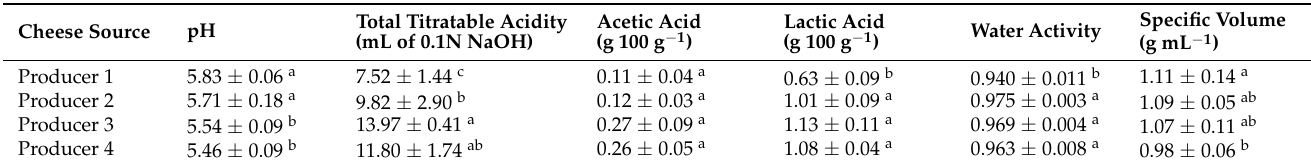
Table 1. Results of physico-chemical analysis of Serra da Estrela PDO